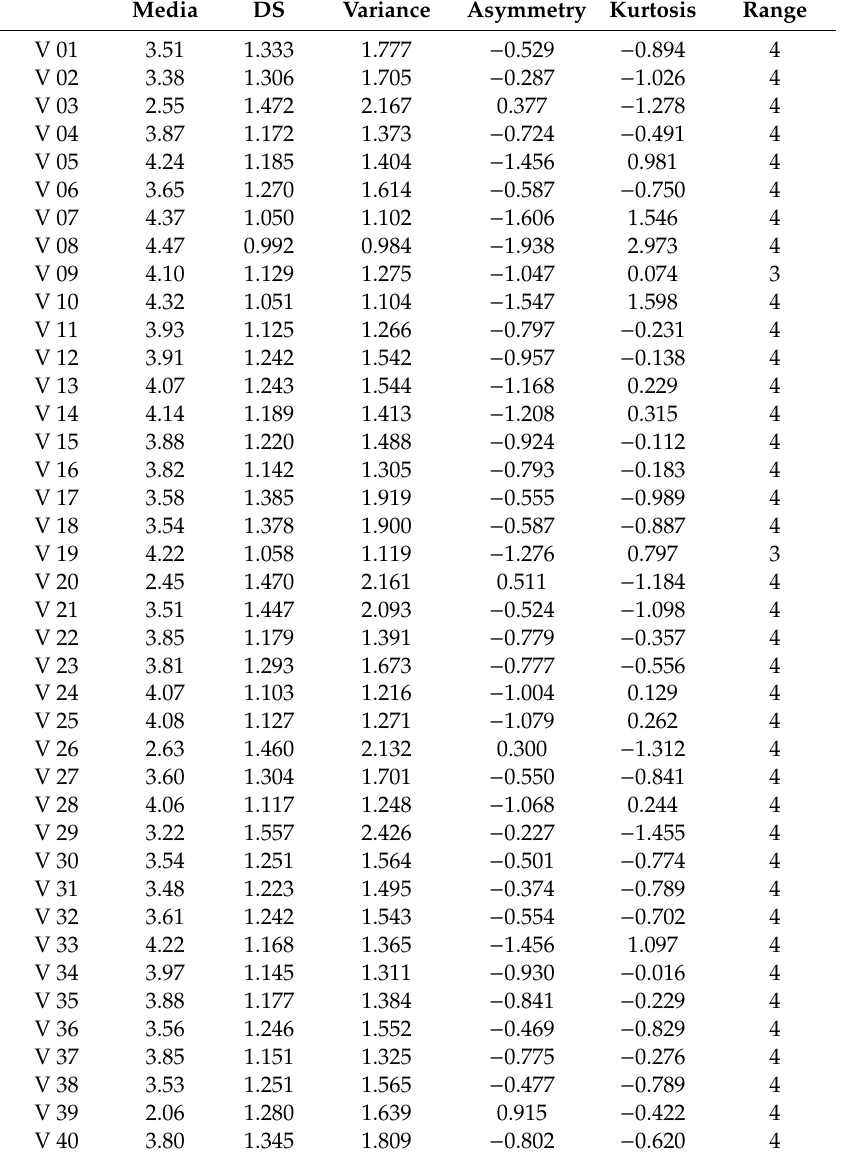
Table 2. Descriptive statistics for items of the Motivation and Learning Strategies Questionnaire-Short Form